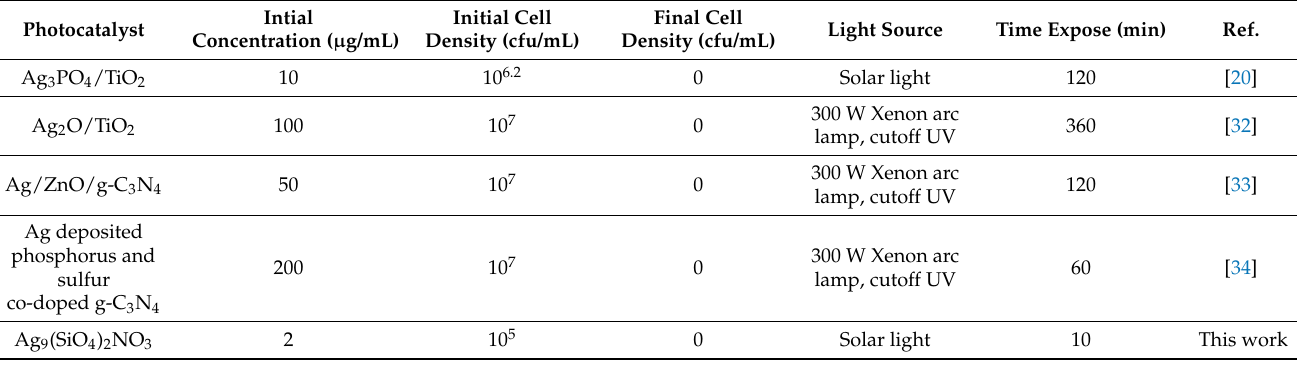
Figure 6. The photocatalytic bactericidal mechanism of Ag 9 (SiO 4 ) 2 NO 3 under sunlight. Table 1. Comparison of the performance of Ag 9 (SiO 4 ) 2 NO 3 with other photocatalysts reported in the literature using ( E. coli)